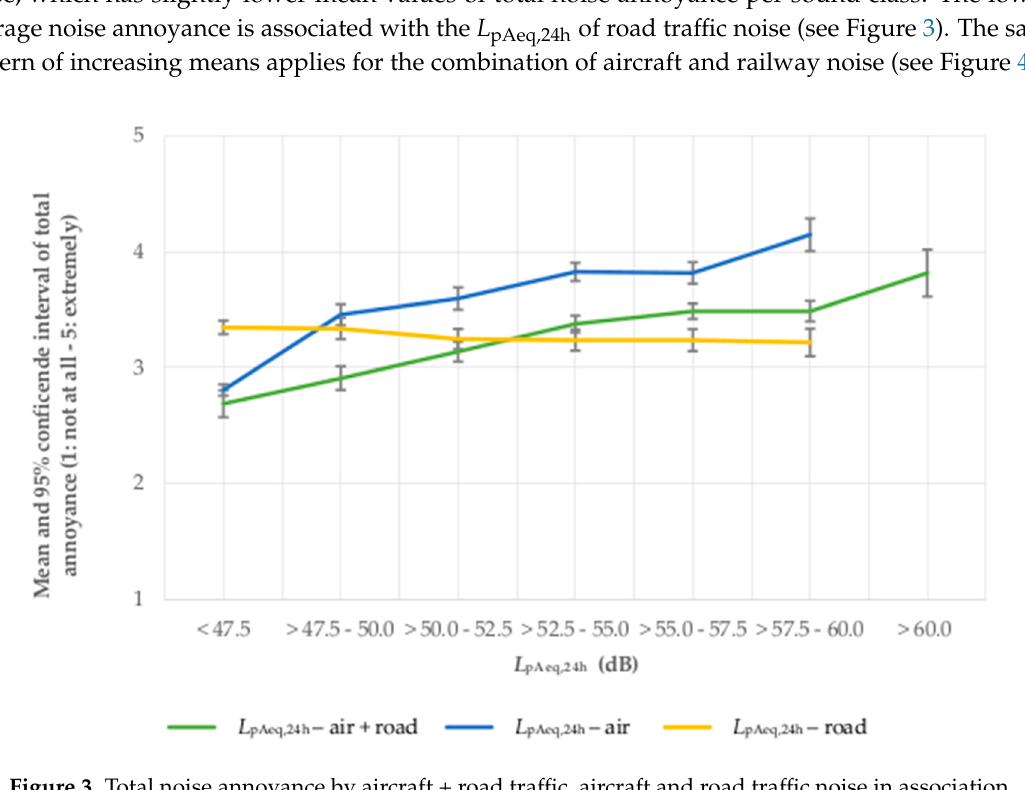
Figure 4. Total noise annoyance by aircraft + railway, aircraft and railway noise in association with the 24 ‐ h average sound pressure level of aircraft + railway, aircraft and railway noise. The analysis of means also shows that total noise annoyance rises continuously in accordance with the increase of the L pAeq,24h of aircraft + road traffic noise, irrespective of the physical dominance